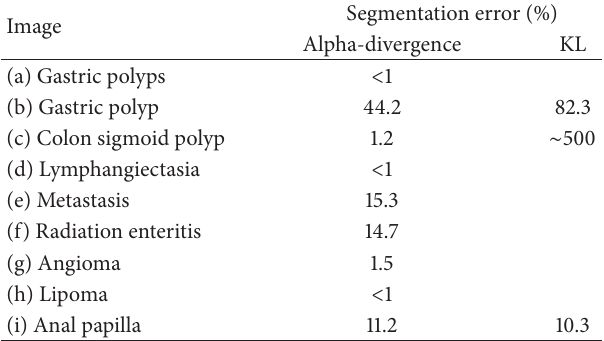
Table 2: Average segmentation error in percentage of misclassified pixels with respect to the divergence